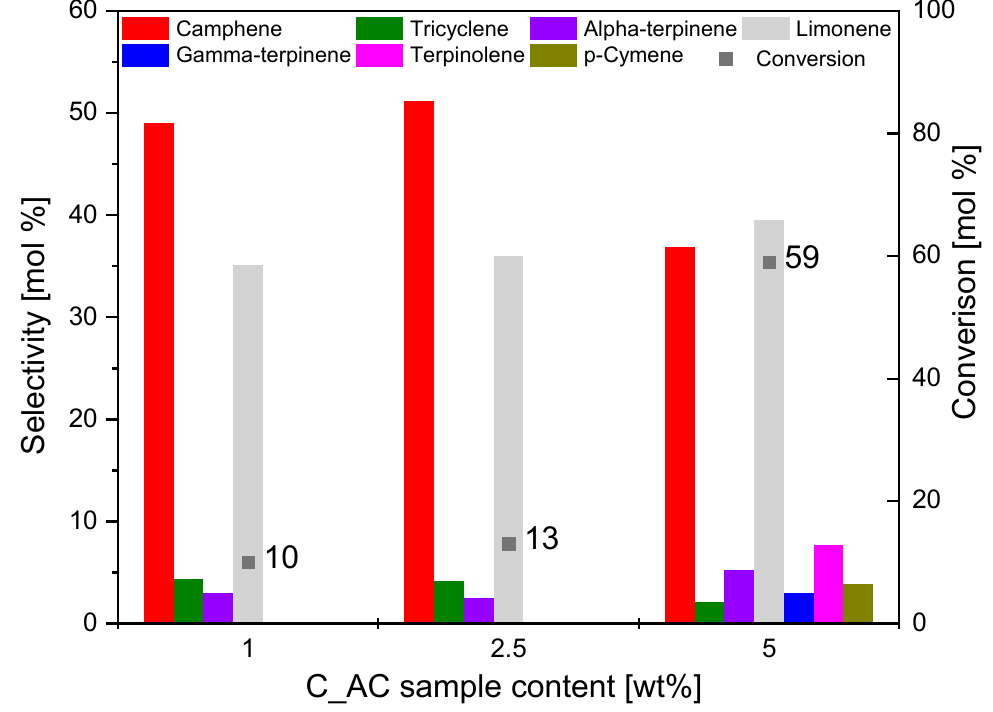
Figure 8. Influence of the C_AC sample content on the selectivity of the main products and conversion of organic raw material (alpha-pinene) after 3 h.